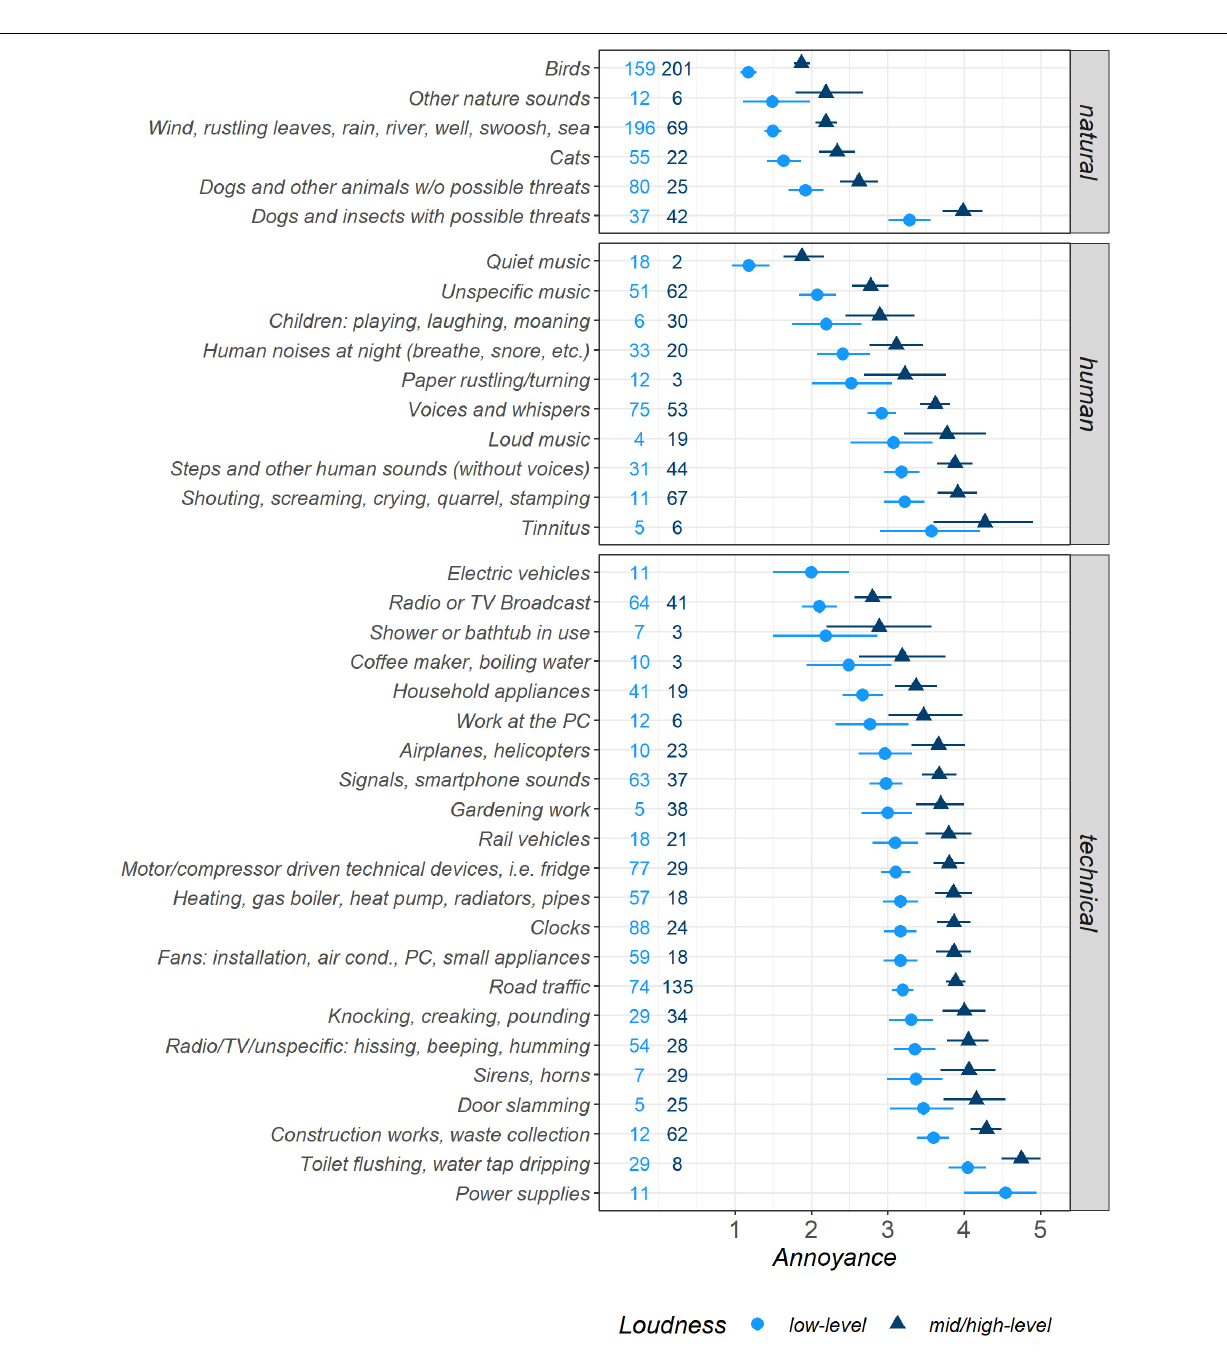
FIGURE 3 | Estimated marginal means for Annoyance for sounds from 38 micro-level sound categories , separated by binary Loudness levels, displayed with 95% confidence intervals (both determined by bootstrapping) and the numbers of observations per category and Loudness level subsets. Very pleasant = 1, very annoying = 5. Model Micro2